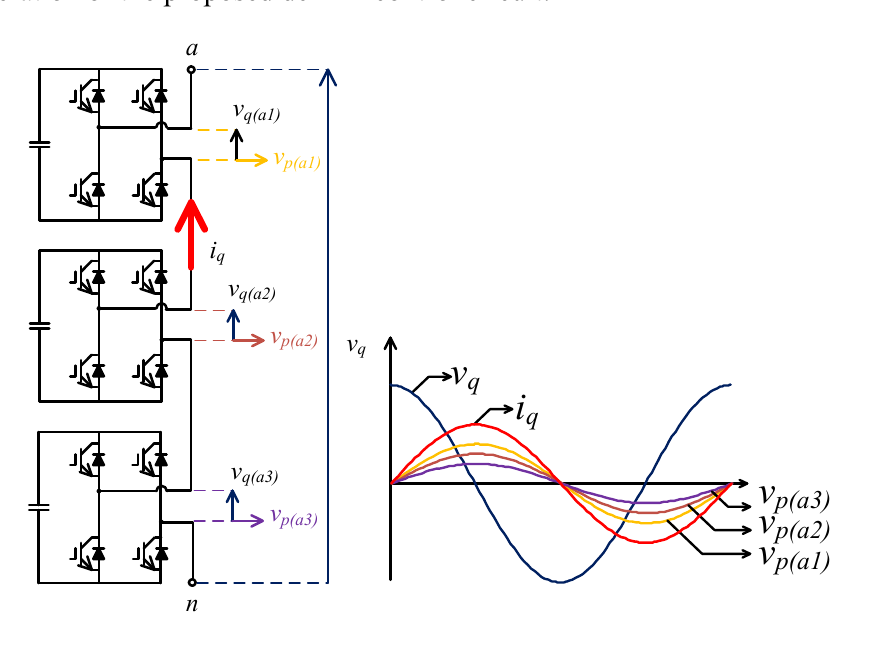
Figure 6. Principle operation of dc link